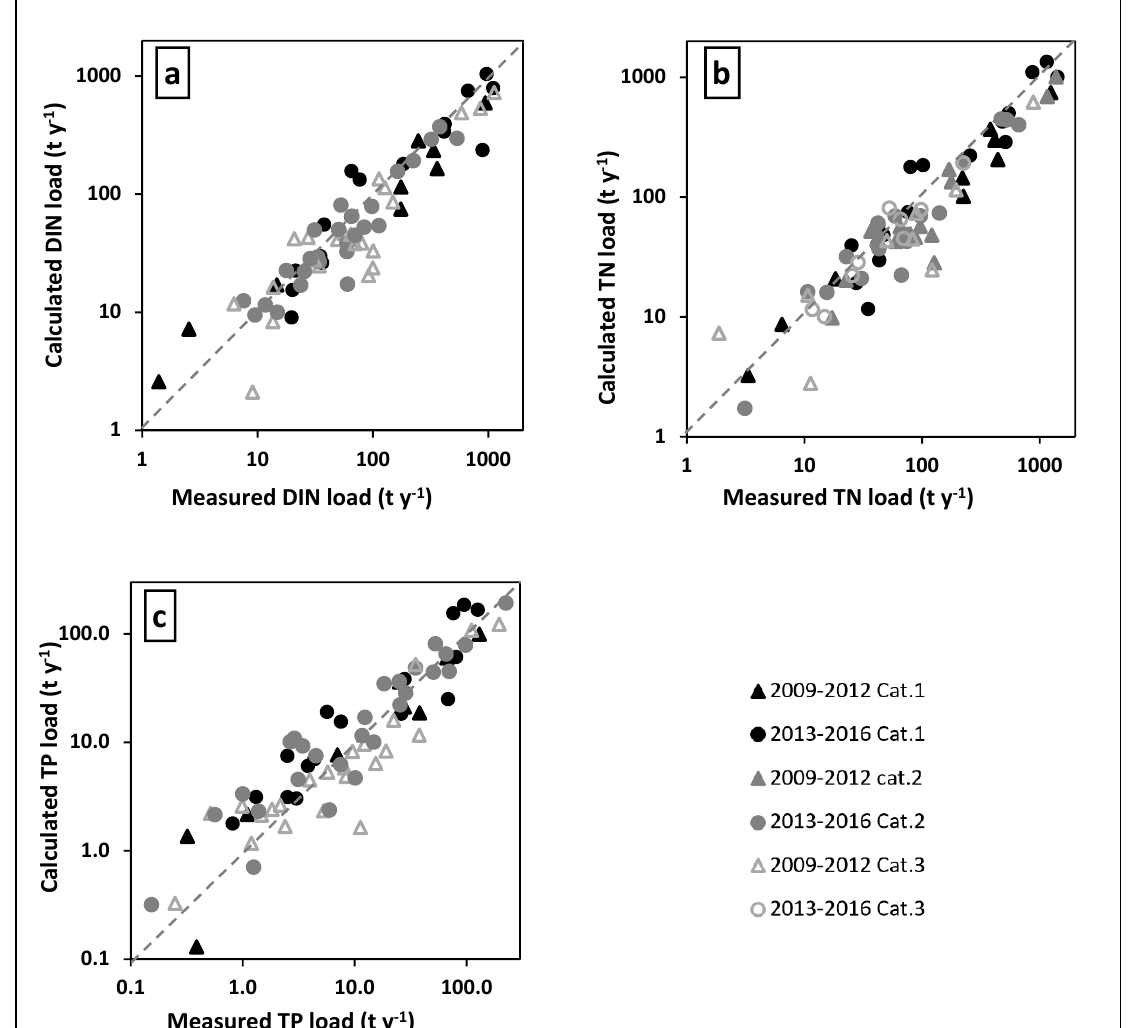
Figure 7. Measured and calculated loads at all monitoring stations. ( a , b , c ) shows the validation results of DIN/TN and TP loads respectively.